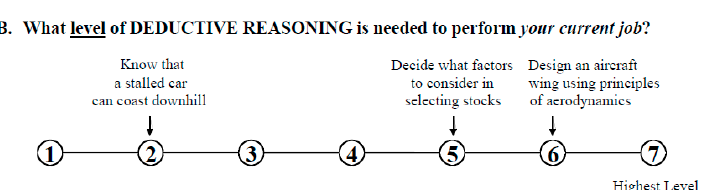
Figure 2 . Sample item from the O*NET Abilities Questionnaire.